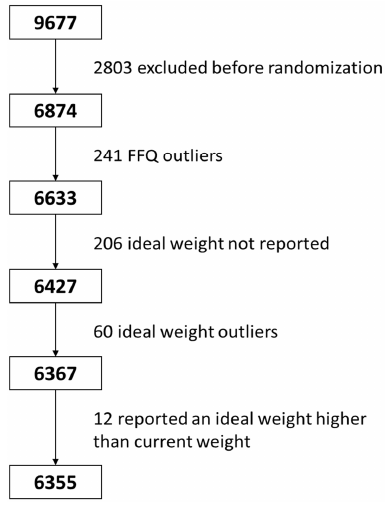
Figure 1. Flow chart of participants.